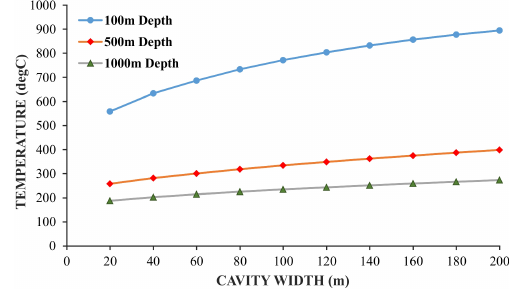
Figure 16. Effect of cavity width and depth on